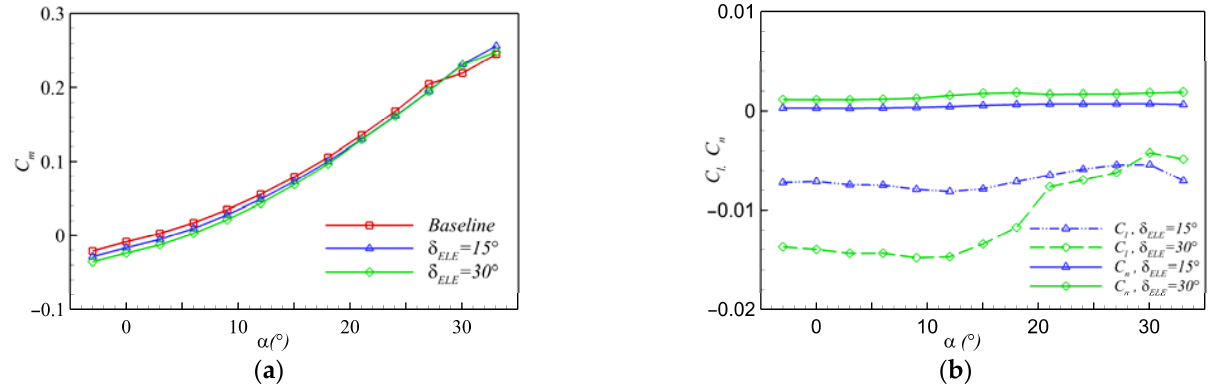
Figure 7. Control characteristics when the elevon deflects alone for Ma = 0.2, Re = 3.98 × 10 7 : ( a ) Pitching moment; ( b ) Rolling and yawing moments.